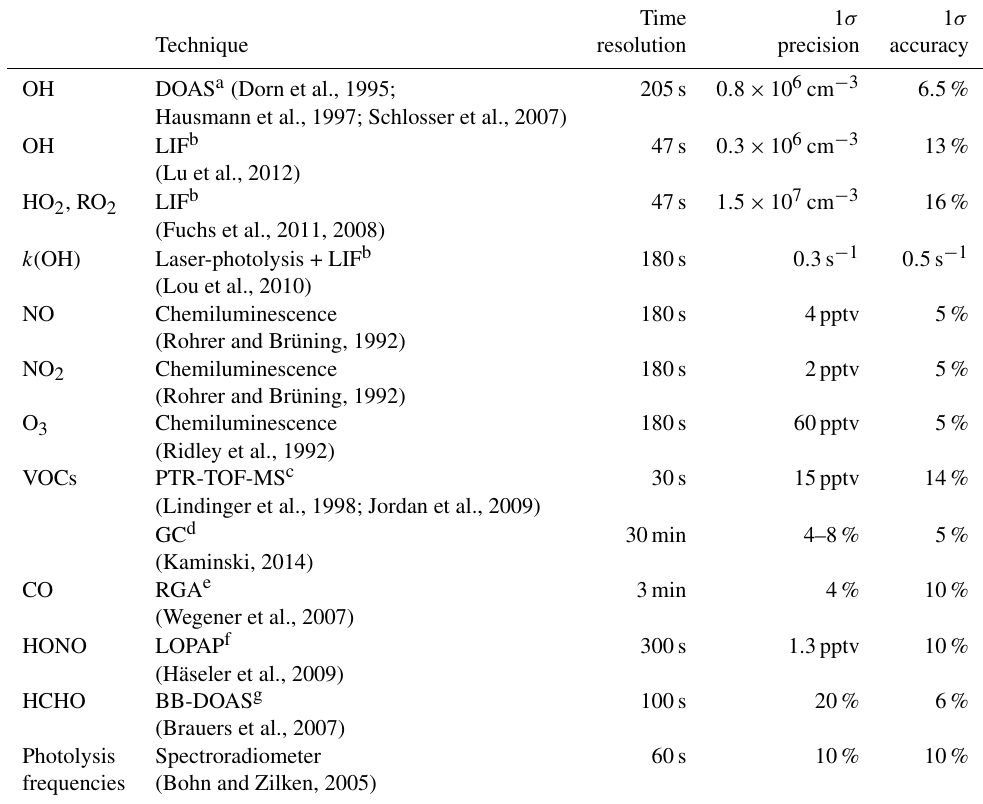
Table 1. Instrumentation for radical and trace-gas detection during the β -pinene oxidation experiments.